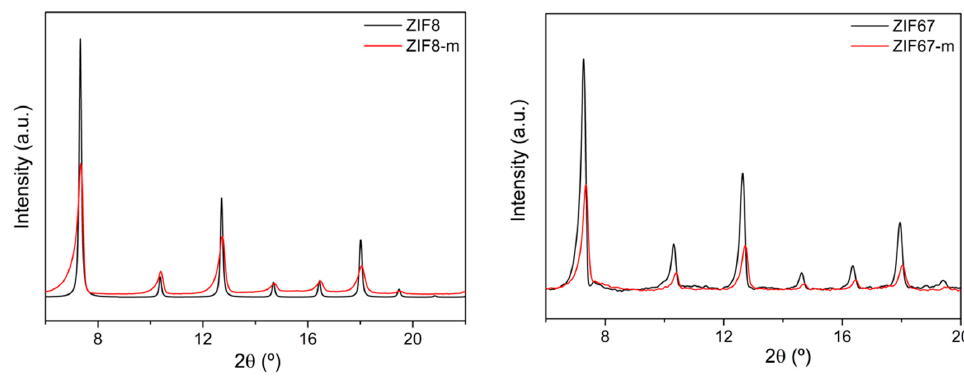
Figure 1. X-ray diffraction patterns of the four catalysts. Figure 1. X-Ray diffraction patterns of the four catalysts.